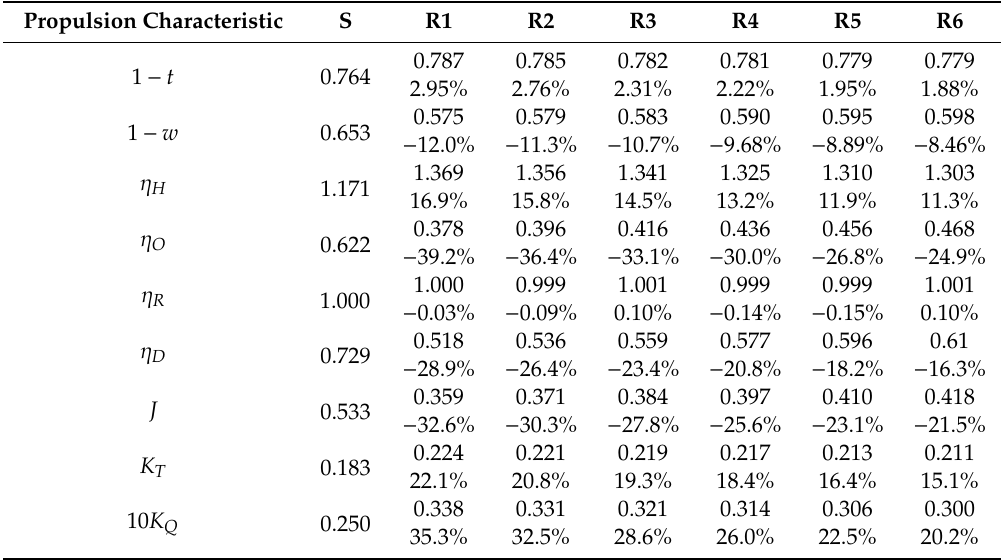
Table 16. The obtained impact of hard fouling on the propulsion characteristics for BC.